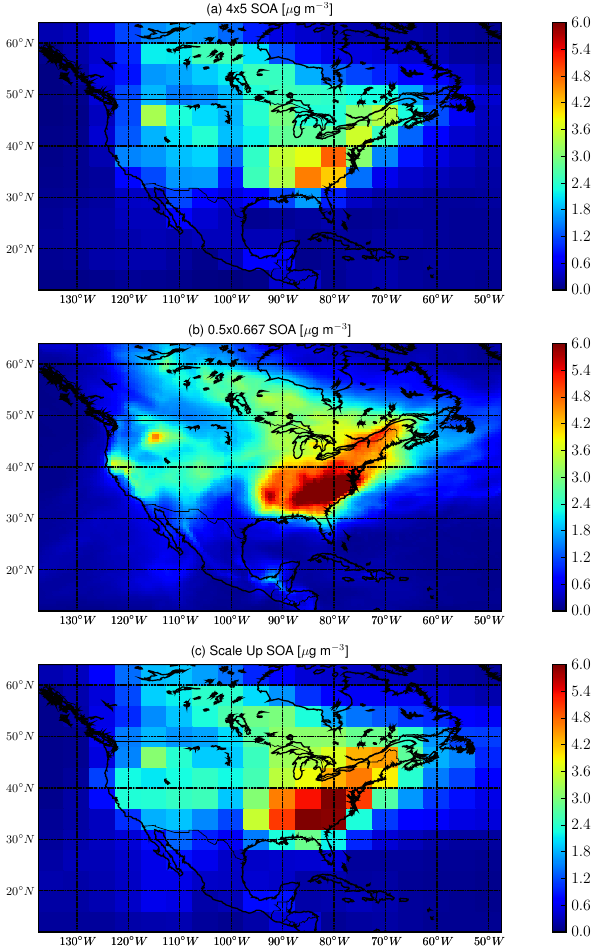
Fig. 5. Averaged SOA concentrations for the month of July over of North America. Panel (a) represents the 4 ◦ × 5 ◦ simulation, (b) the 0.5 ◦ × 0.667 ◦ simulation and (c) the scaled up (SU) average of the 0.5 ◦ × 0.667 ◦ boxes in each 4 ◦ × 5 ◦ box.